Question: Identify the chart type used in this figure.
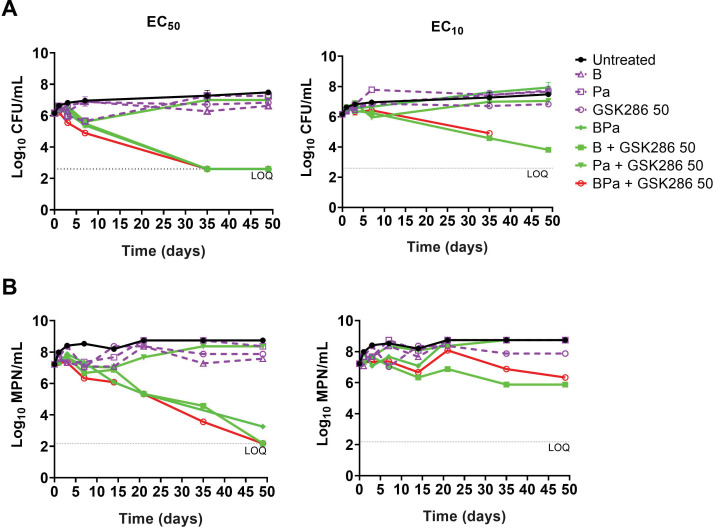
Answer: line